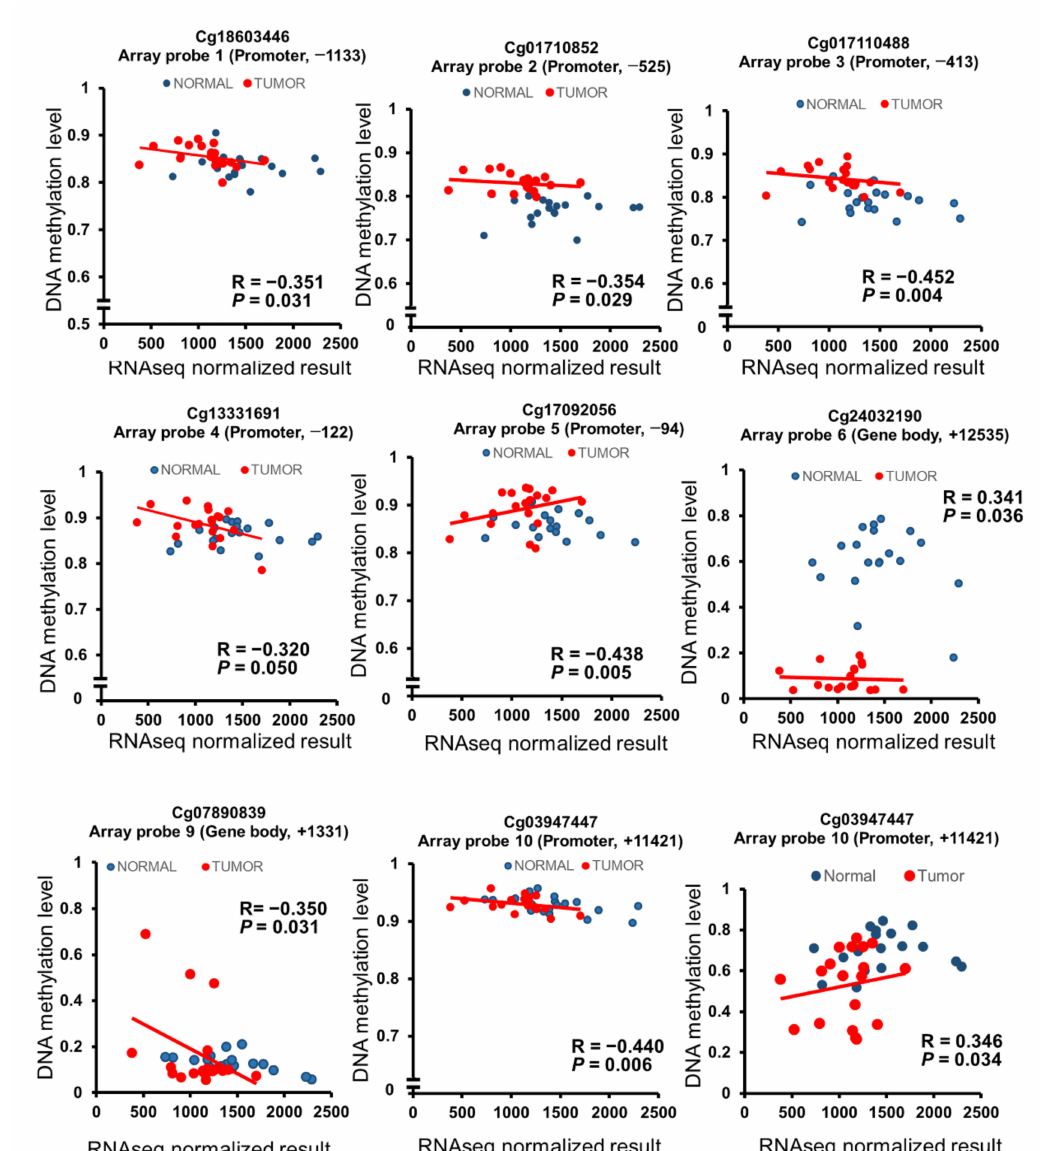
Figure 6. Pearson correlation analysis of tissues between DNA methylation and RNA sequencing in 19 paired adjacent normal tissue samples and 19 paired CRC tissue samples from